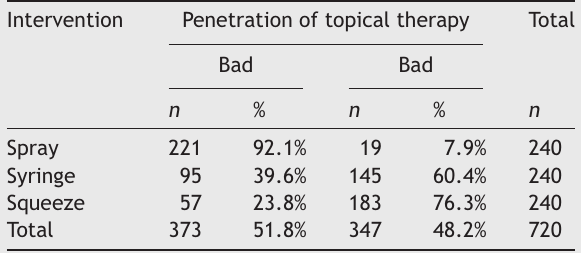
Penetration of topical therapy with Normal Middle Turbinate.